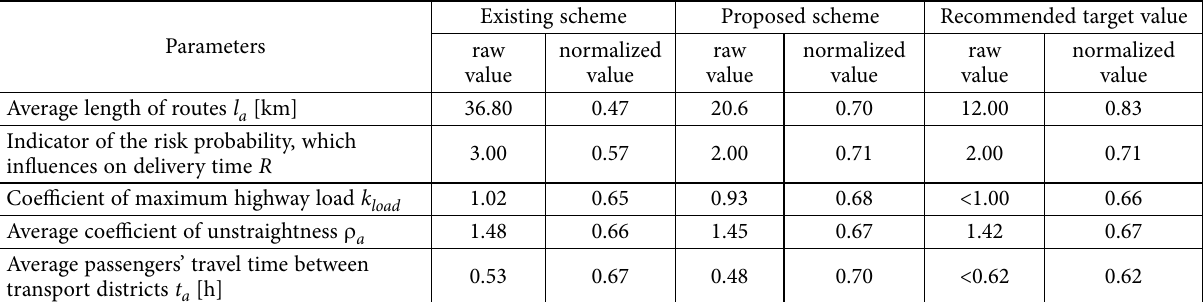
Table 2. Comparison of the main route network’s efficiency